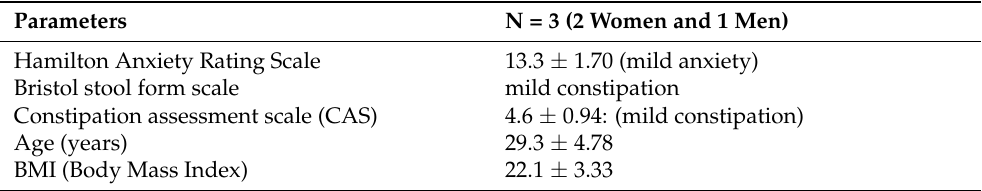
Table 1. Characteristics of fecal pool